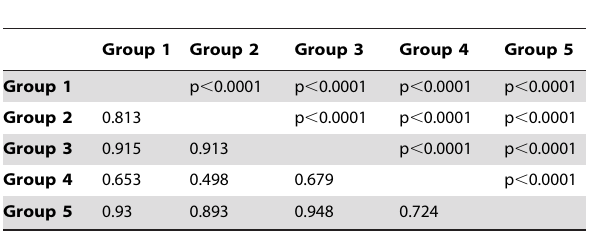
Table 4. Matrix of pairwise W ST values between the five groups.